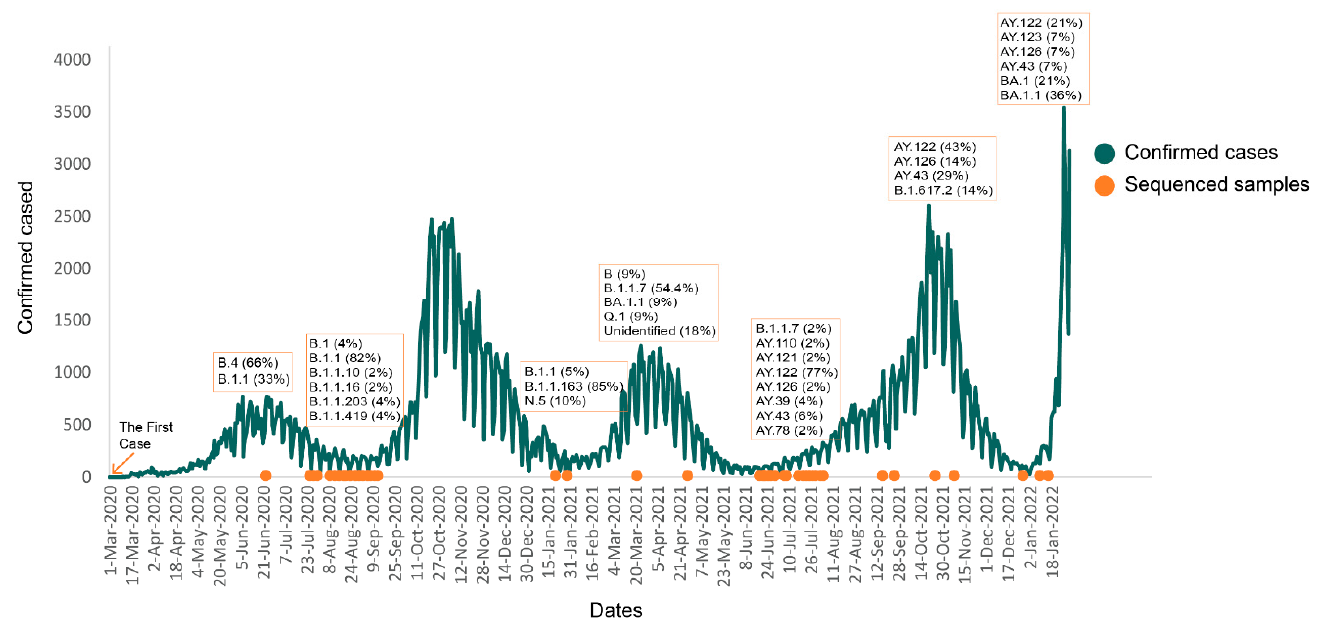
Figure 1. Daily incidence of reported confirmed cases for Armenia, sampling dates, and clade distribution of the sequenced samples.